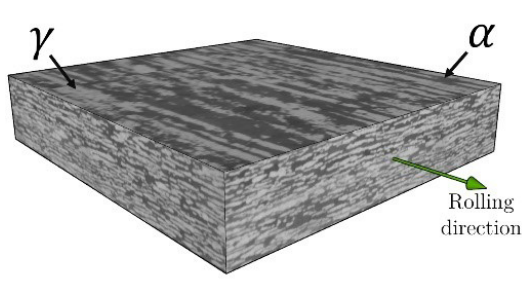
Figure 1. DSS UNS S32205 microstructure, ferrite phase (α: darker) and austenite phase (γ: